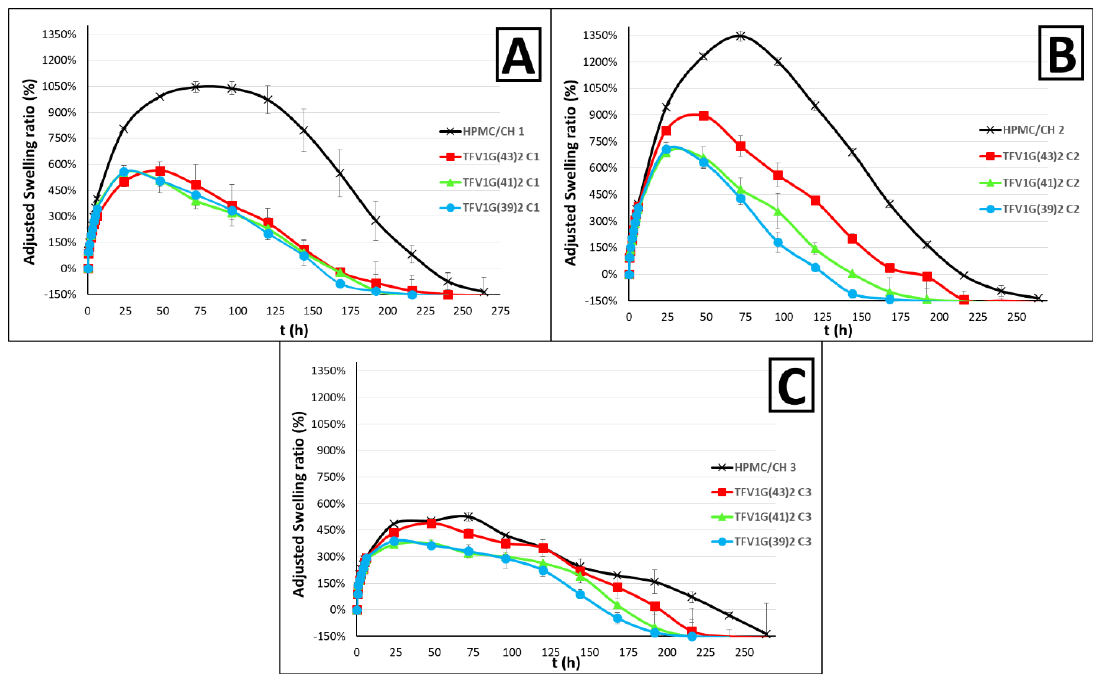
Figure 8. Adjusted swelling ratio profiles obtained from batches containing TFV/Gelucire® (in a 1:2 ratio) granules in HPMC/CH matrices with equal ratios of both polymers ( A ); more HPMC than CH ( B ); and more CH than HPMC ( C ). They are all compared with standard formulations of HPMC/CH [16].